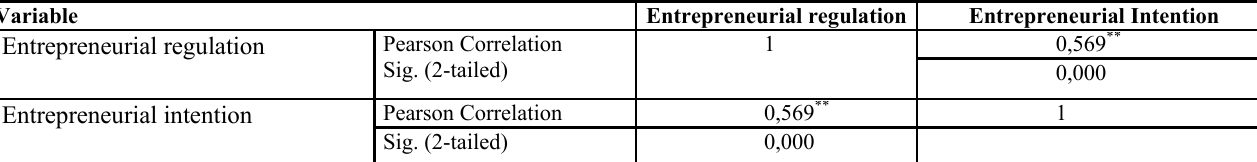
Table 3: Correlation between entrepreneurial regulation and entrepreneurial intention